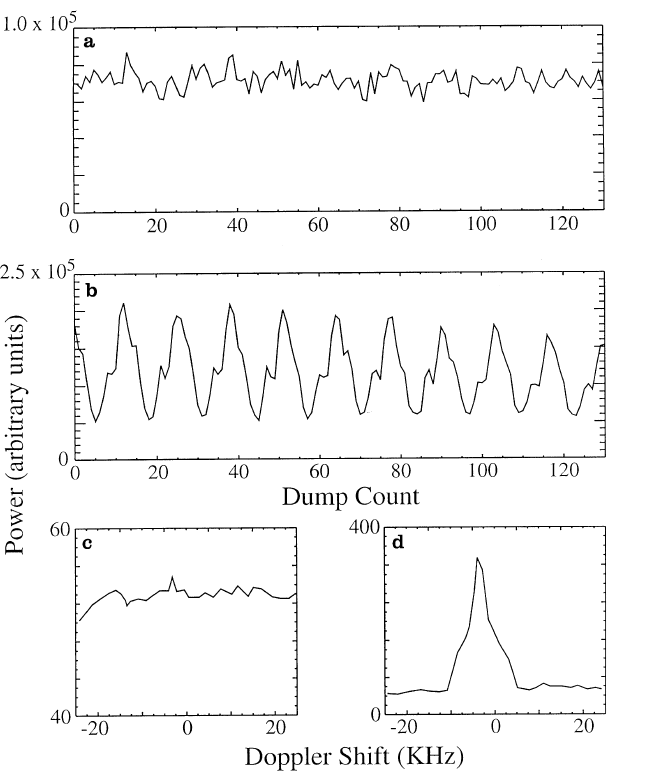
Fig. 2. a typical noisy returns for the Barker part of the experiment are depicted with the corresponding COSC spectrum in panel c . During the observation of coherent spectra at Kiruna, panel d , a 13-point periodicity is observed in the Barker decoded signal detected at Sodankyla¨ , panel b . In the x -axis label of panels a and b one ‘Dump Count’ is the 1-s average of one bit of the Barker code